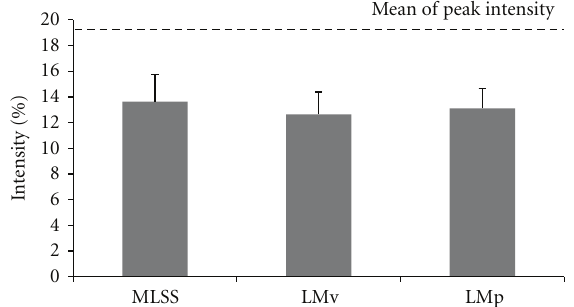
Figure 2: Mean results and standard deviation of intensity (% treadmill inclination) for MLSS, LMv and LMp and the mean peak